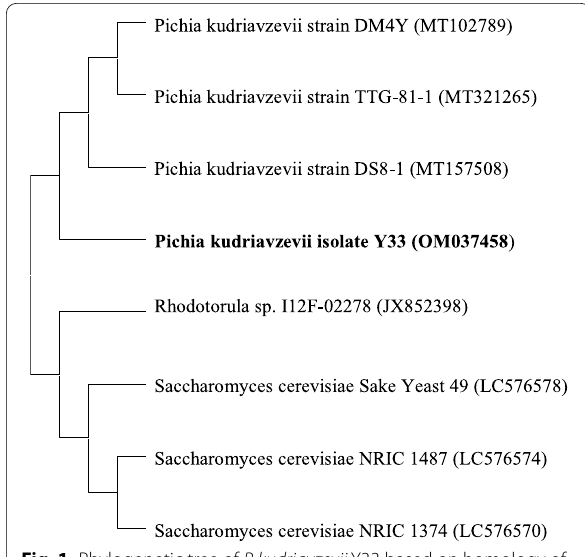
Fig. 1 Phylogenetic tree of P. kudriavzevii Y33 based on homology of ITS gene sequences. Toluene showed significantly high cell surface hydrophobicity at p < 0.05 as measured by 2 sided Tukey’s post hoc range test between replications